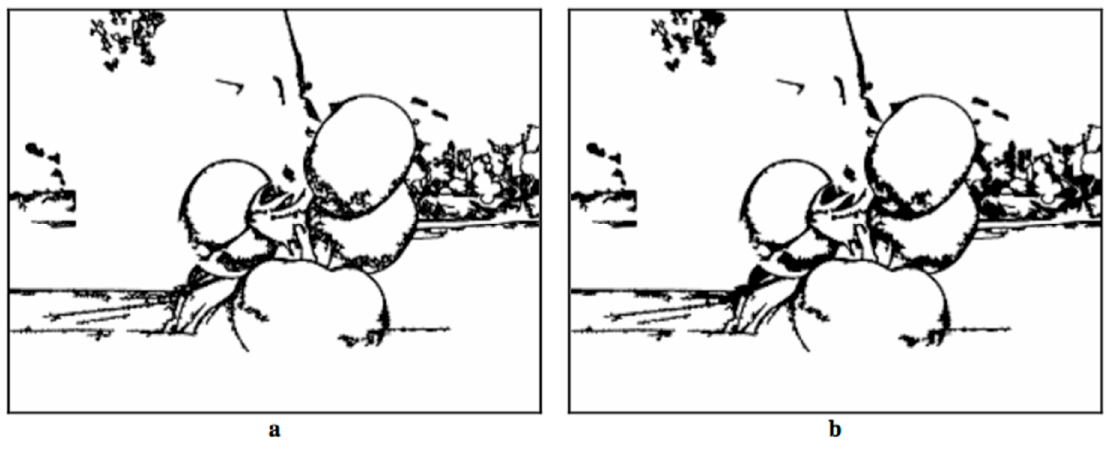
Figure 8. ( a ) Binary inversion; and ( b ) size segmentation.